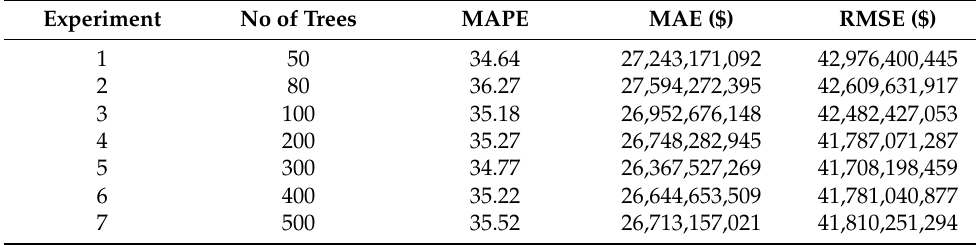
Table 3. Revenue loss prediction error of different experiments for the thunderstorm category.